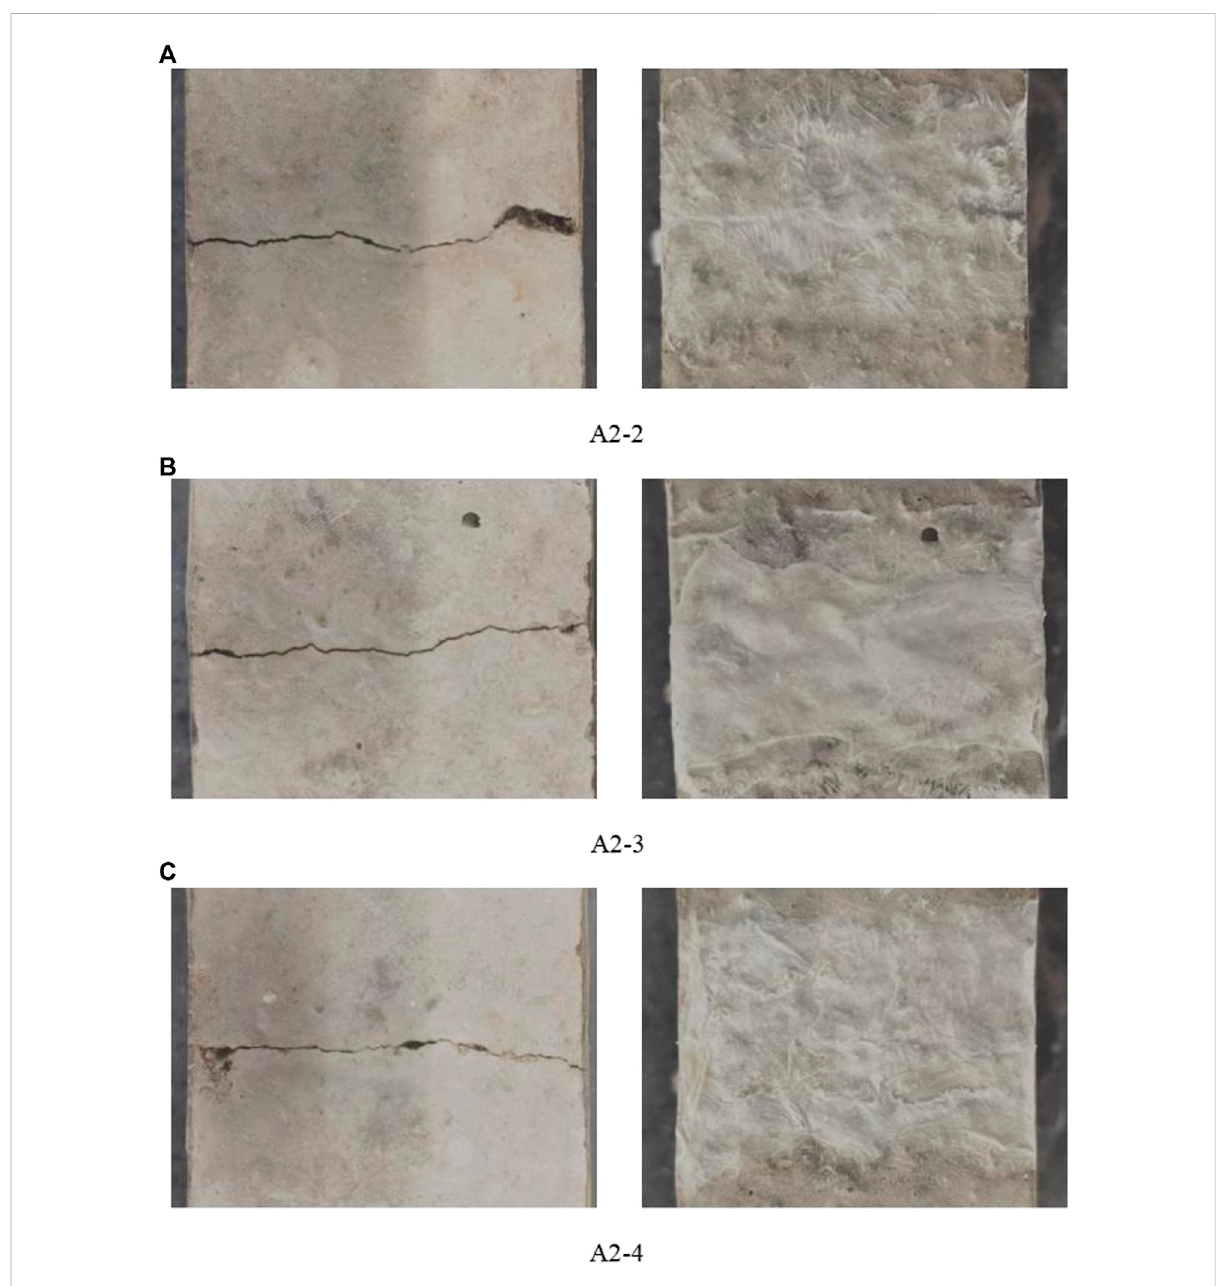
FIGURE 9 Macroscopic morphology of mortar surface cracks before and after repair [ (A) A2-2, (B) A2-3, (C)